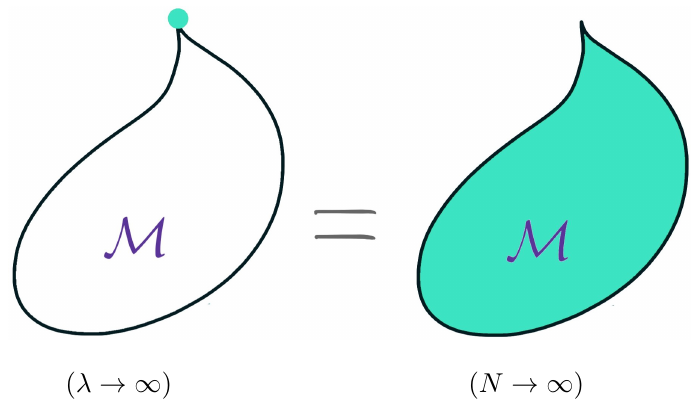
Figure 1. A cartoon depicting the two equivalent field theory duals of type IIB supergravity on AdS 5 × S 5 , phrased in terms of the conformal manifold M : as the limit of large ‘t Hooft coupling (depicted by the point approaching the cusp of M ) of planar N = 4 SYM (left), and as the large N limit of the ensemble average (denoted by the shading) of N = 4 SYM (right). On the left it is understood that the N → ∞ limit is taken